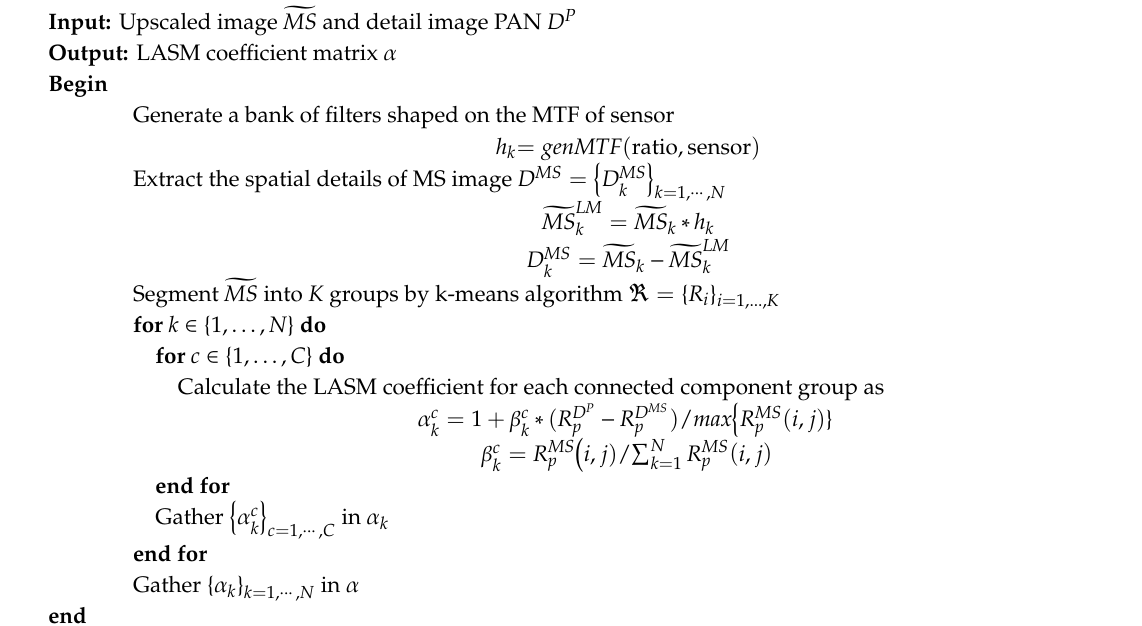
Algorithm 1 Generating LASM coe ffi cient